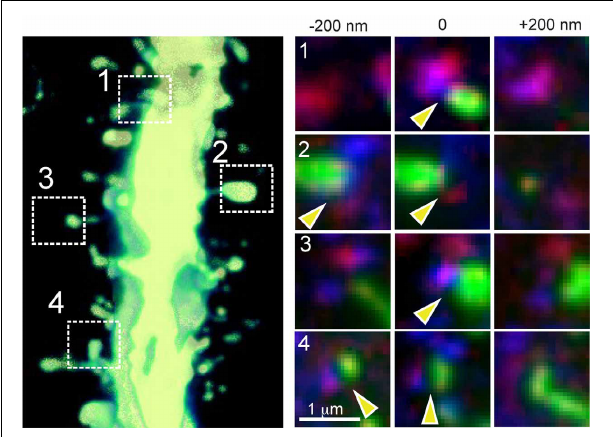
FIGURE 3 | TC synapse detection by AT. High power view of a section of dendrite of an YFP-expressing L5 pyramidal neuron with four example thalamo-recipient spines indicated (left panel; 3-D volume rendering of 13 serial sections = 2.6 µ m thick). Right panels: images from three serial sections showing spine (YFP signal, green), TC terminal (tdTomato, red) and synaptophysin staining (blue) for each of the four indicated example TC synaptic contacts. Yellow arrowheads indicate locations of identified synaptic contacts (note that for synapses 2 and 4, the synaptic contact is detected in two of the images).